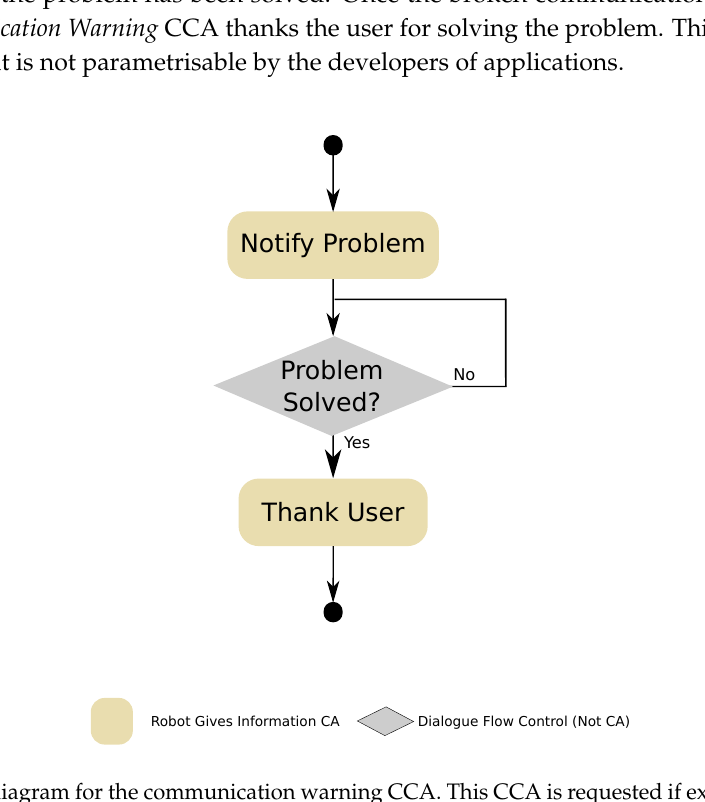
Figure 7. Flow diagram for the communication warning CCA. This CCA is requested if external peripherals used by the robot stop working. The CCA requests help from the user, waits for the problem to be solved and then thanks the